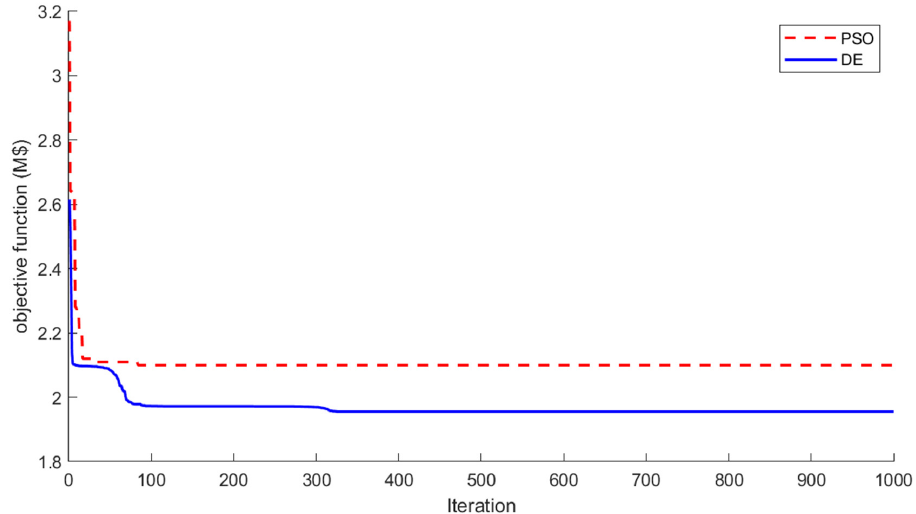
Figure 11. Convergence characteristics of the DE and PSO algorithms for case 2.